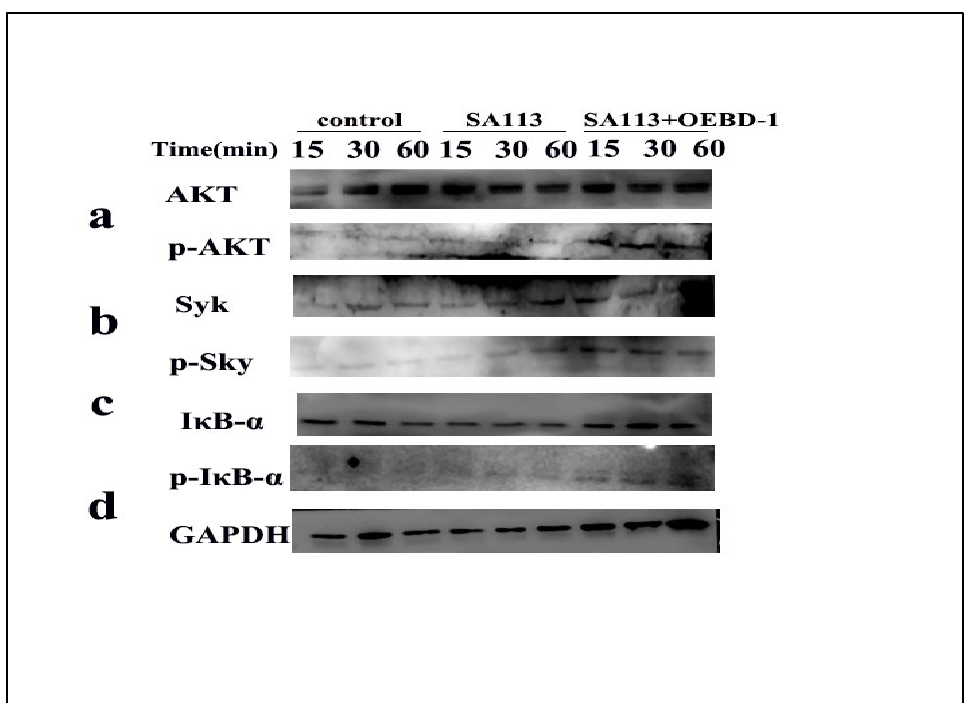
Figure 5. Macrophage J774A.1 in vitro were infected with SA113 at MOI = 40:1 or SA113 with 10 ug/mL OEBD-1 for 15 min, 30 min, and 60 min. Western blotting was used to assess GAPDH ( d ), non-phosphorylated and phosphorylated AKT ( a ), Syk ( b ), and IκB - α ( c ).